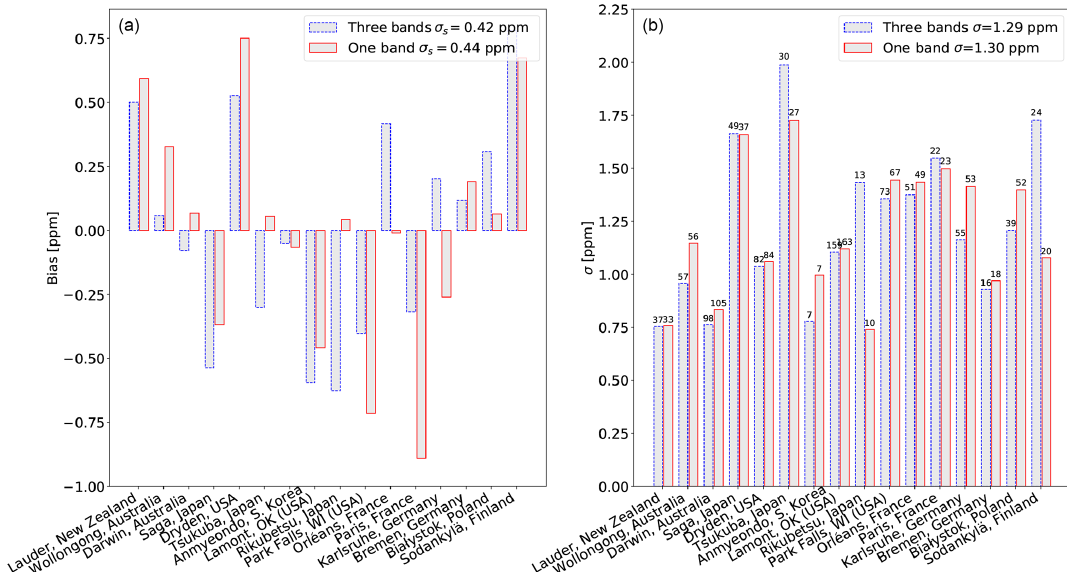
Figure 2. Bias (a) and standard deviation (b) variation at different TCCON stations for one-band and three-band retrievals over land. To see the bias variation on the same reference level, we directly subtract mean bias b a of one-band and three-band retrievals accordingly as listed in Table 3. The station-to-station variability ( σ s ) is included in the legend of (a) . In (b) , the number of overpass at each station is listed on the bar. The TCCON stations are ordered by latitude from Southern Hemisphere to Northern Hemisphere. Stations with fewer than five overpasses are